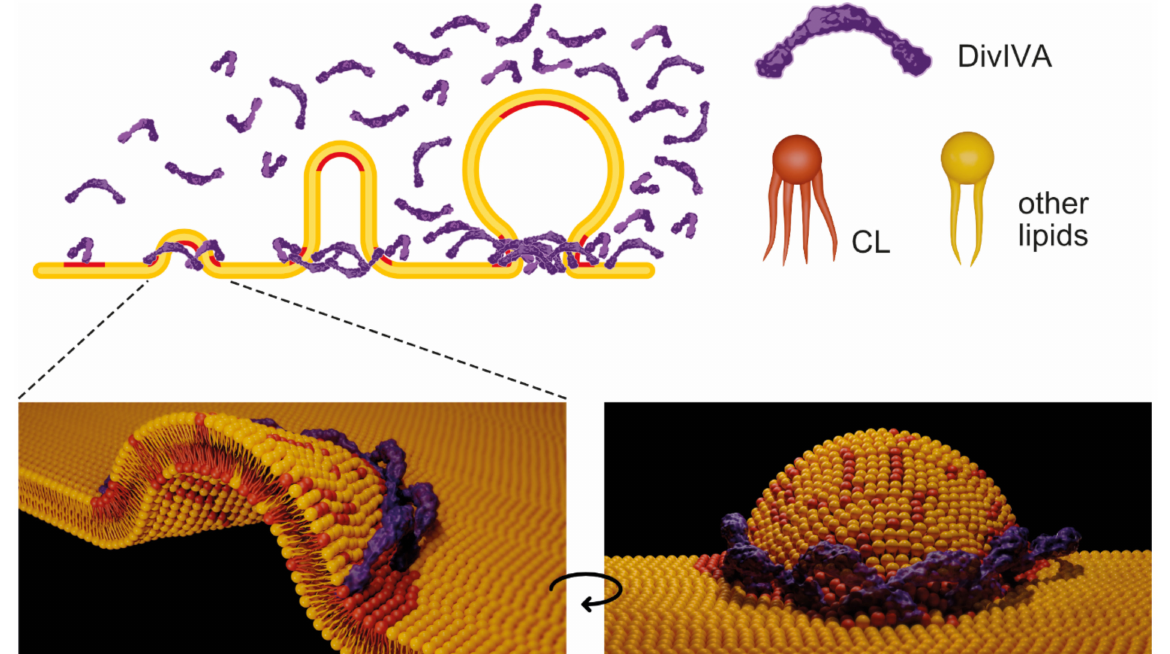
Figure 6. Model of DivIVA Cd membrane binding. DivIVA Cd preferentially binds to membrane areas with an increased cardiolipin concentration. Bound DivIVA Cd attracts more DivIVA Cd molecules and cardiolipin to these areas. The bilayer morphology is heavily distorted, and curvature develops. This, in turn, causes more cardiolipin to sort towards these areas and enhance DivIVA Cd binding. The DivIVA Cd illustration (violet) is based on the structure of the full-length DivIVA Bs tetramer [38]. This illustration is simplified, however, as the protein forms higher order structures, and the shape and rigidity of these structures are likely to play a role in bilayer shaping. Cardiolipin (CL) is highlighted in red, other lipids are in